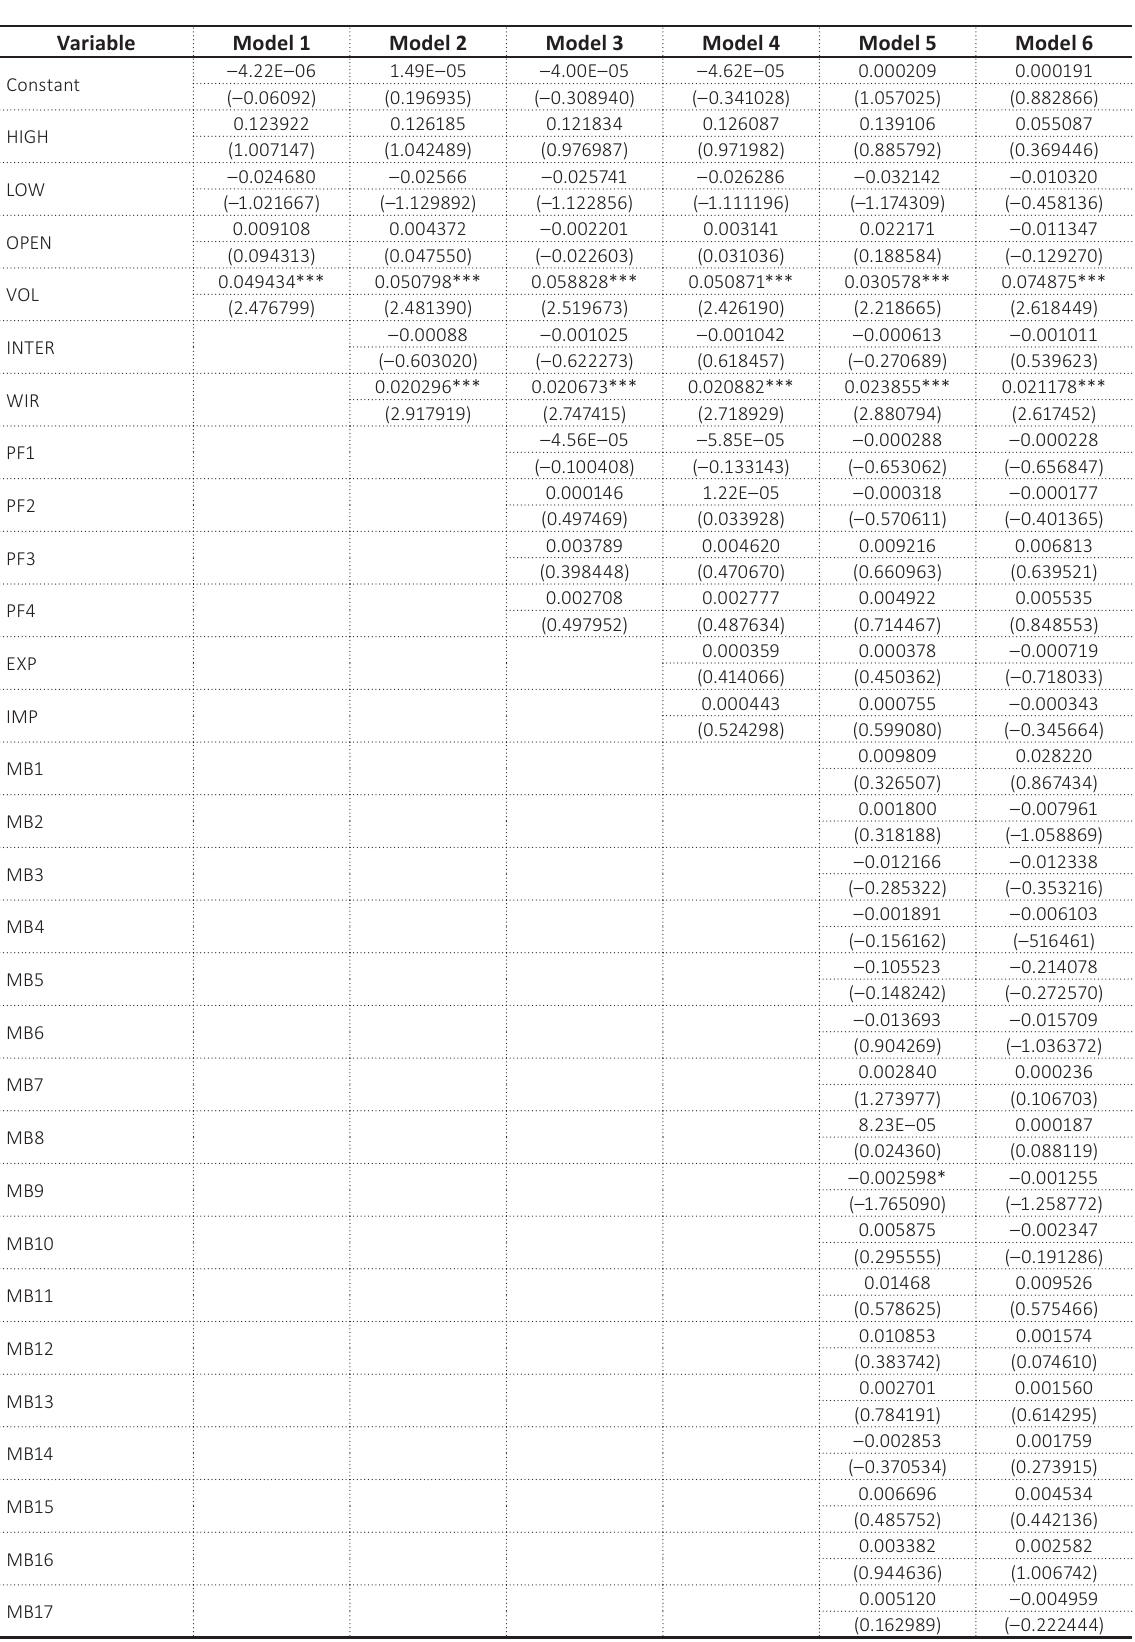
Table 4. Estimates from the baseline